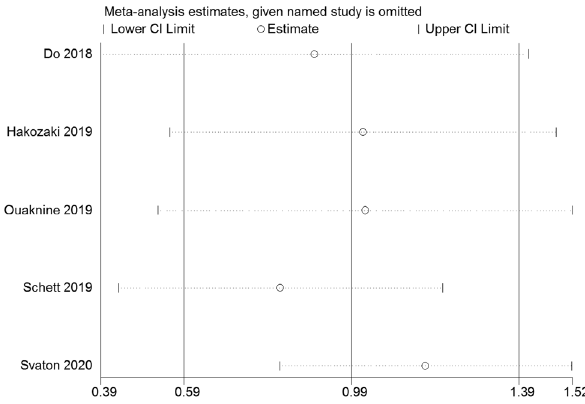
Figure 9: Sensitivity analysis of the studies assessing